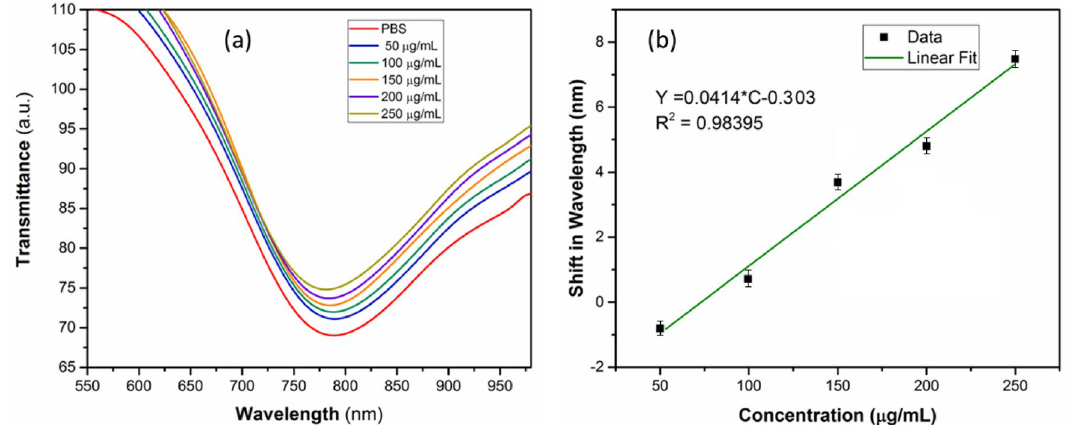
Figure 8. ( a ): SPR wavelength shifts of the Ab(IgG)/L-Cysteine/MoS 2 /OF-SPR biosensor with respect to different concentrations to IgG; ( b ): Corresponding linear calibration curve, all measurements are an average of 3